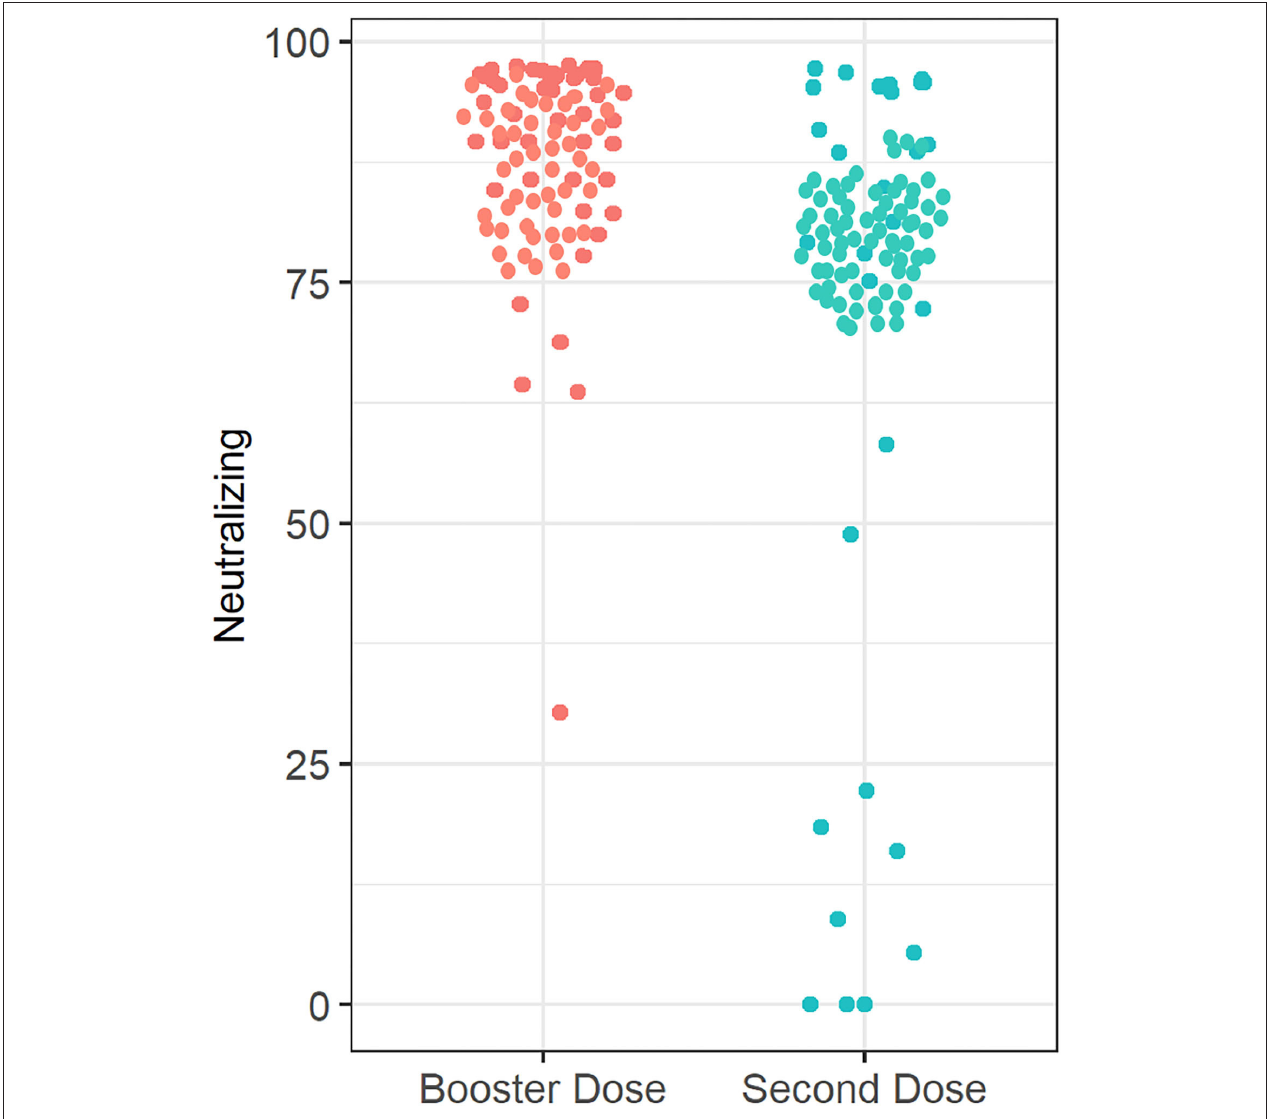
FIGURE 3 | Anti-SARS-CoV-2 neutralizing antibody concentrations in patients receiving infliximab combination therapy after the second and third (booster) dose. The median anti-SARS-CoV-2-neutralizing antibody concentration after receiving the second dose is 80%, whereas the median neutralizing antibody concentration was 96% after receiving the third (booster)